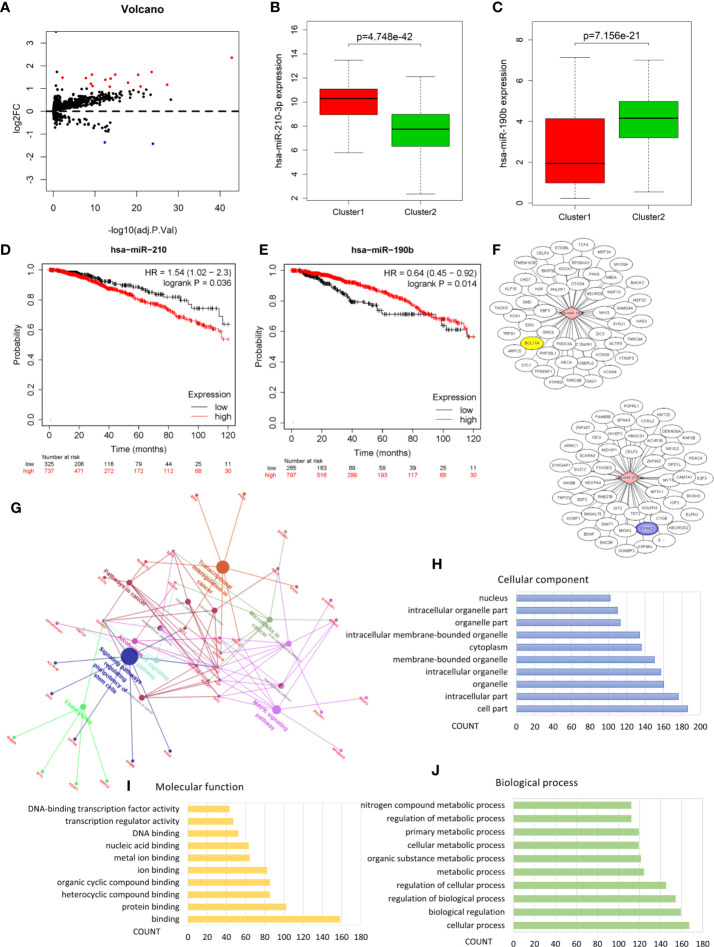
Identification of hypoxia associated differentially expressed candidate microRNAs. (A) Volcano plot for differentially expressed microRNAs in cluster1 and cluster2. Red and blue dots represent up-regulated and down-regulated in cluster1 relative to cluster2, respectively (P < 0.05, |logFC| >1). (B, C) The expression of hsa-miR-210-3p and hsa-miR-190b in cluster1 and cluster2. (D, E) The overall survival curves of hsa-miR-210-3p and hsa-miR-190b in TCGA BRCA estimated by the Kaplan Meier plotter. (F) The miRNA-mRNA networks for the top50 targets of hsa-miR-210-3p and hsa-miR-190b. (G) KEGG pathway enrichment analysis of the target genes of hsa-miR-210-3p and hsa-miR-190b. (H–J) The top 10 items of GO analysis: biological processes, molecular functions and cellular components of the target genes of hsa-miR-210-3p and hsa-miR-190b.